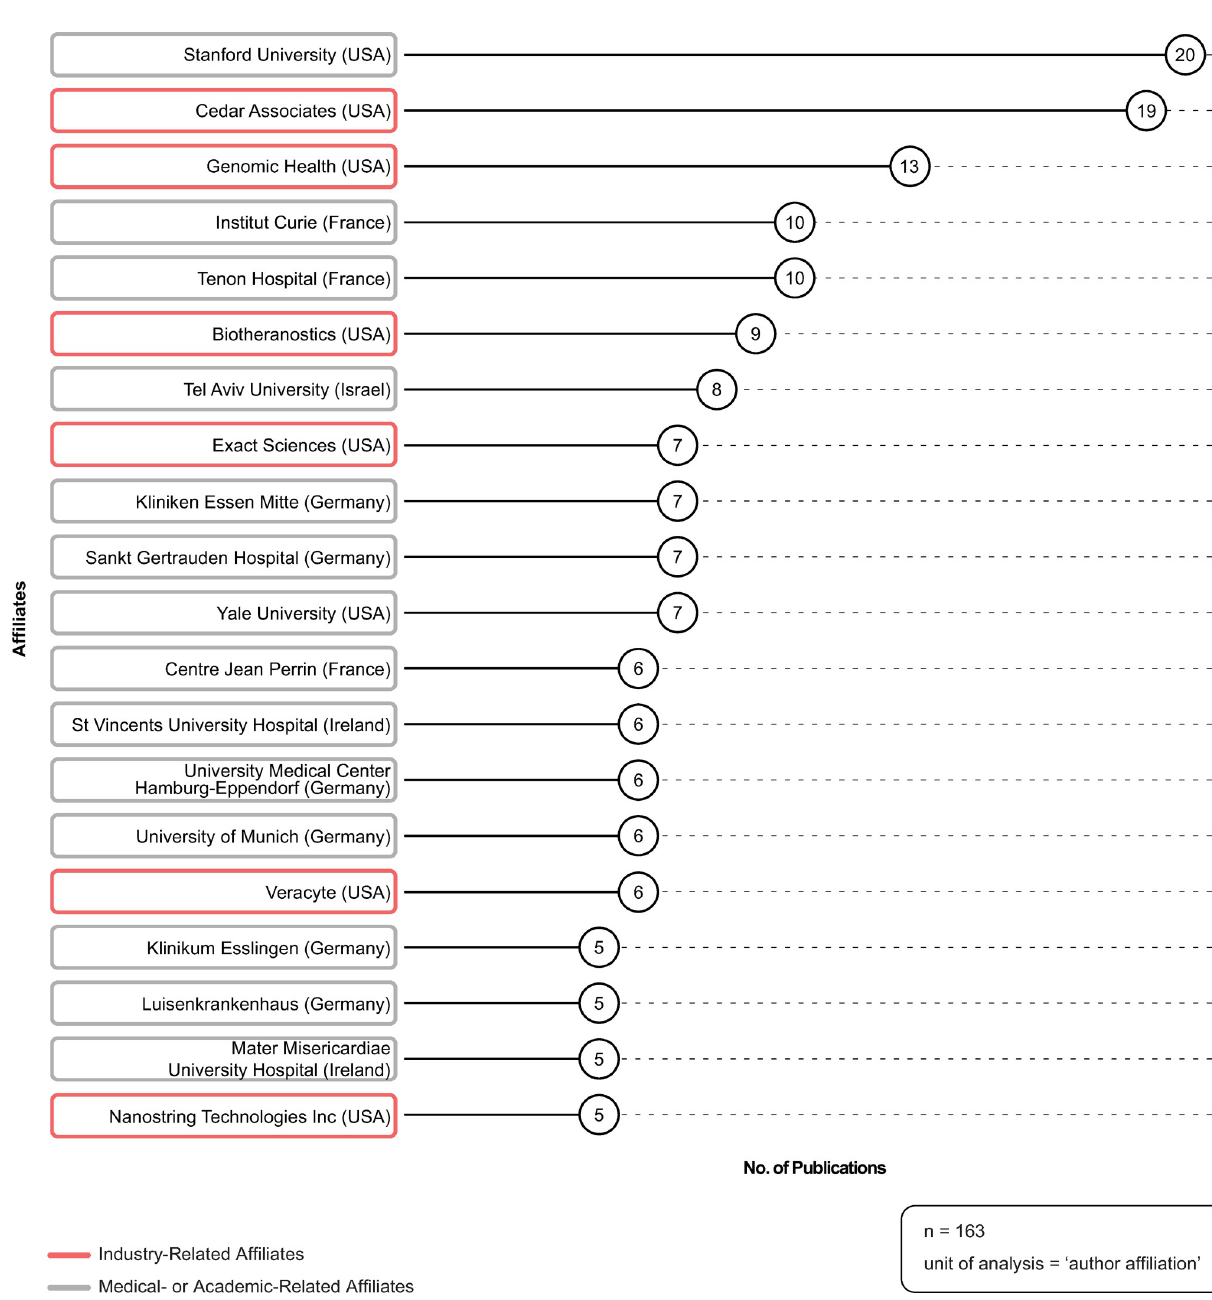
Fig 6 depicts the publication collaboration networks between authors. Each circle, or ‘node’, represents one author. Each line connecting two nodes represents at least one publication col- laboration between authors; the shorter the line, the stronger the publication collaboration between authors (i.e., the more shared publications). Publication collaboration networks were